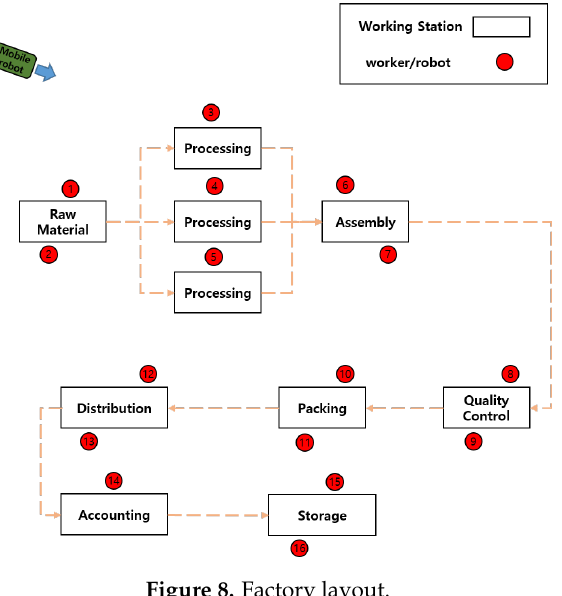
Figure 8. Factory